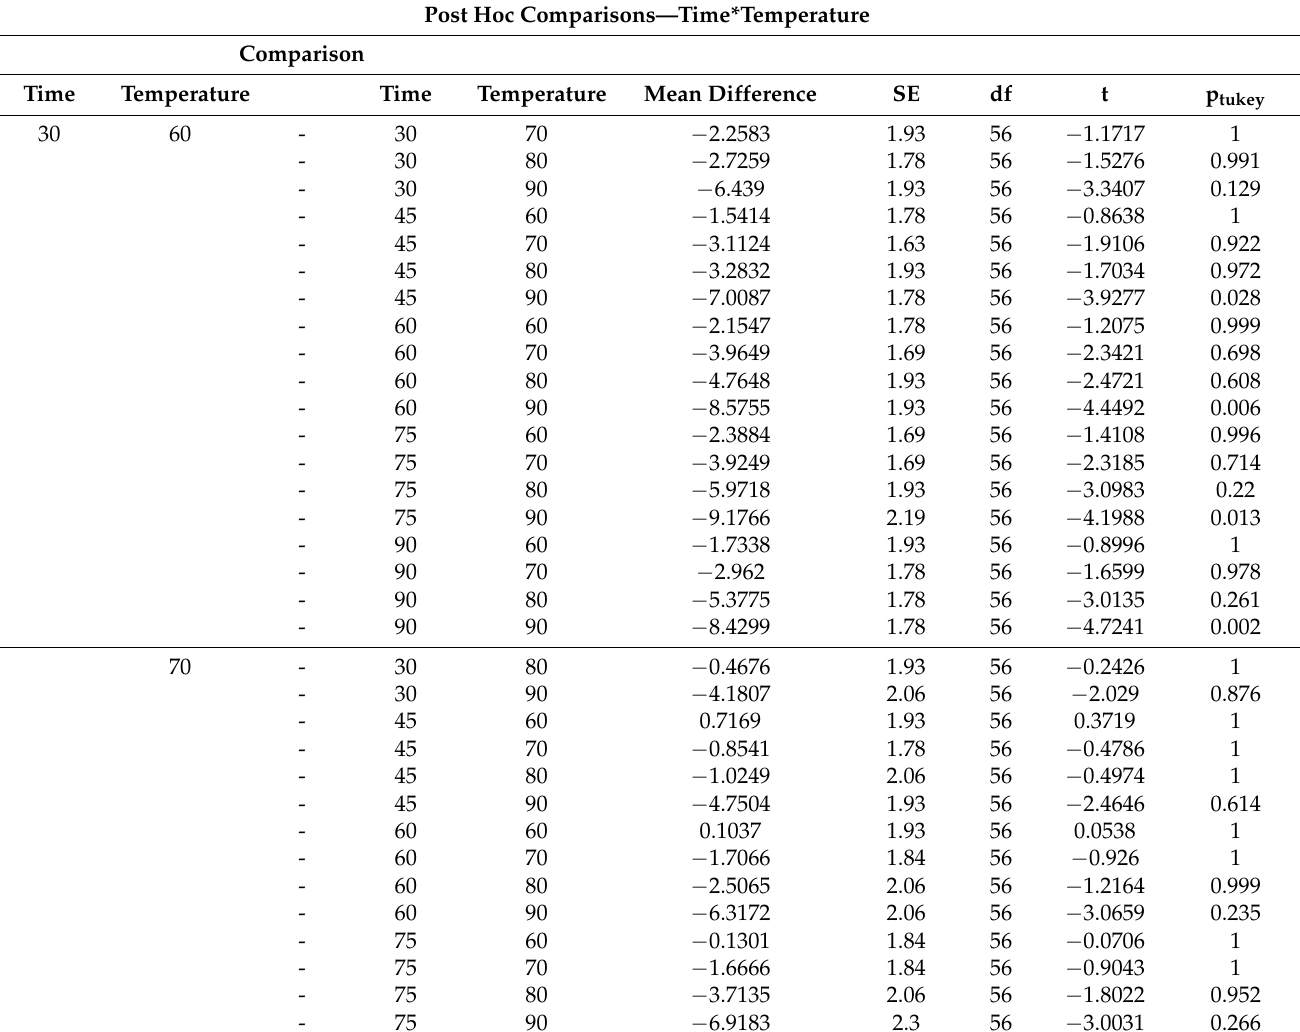
Table A4. Tukey test for time*temperature treatments in pectin yield